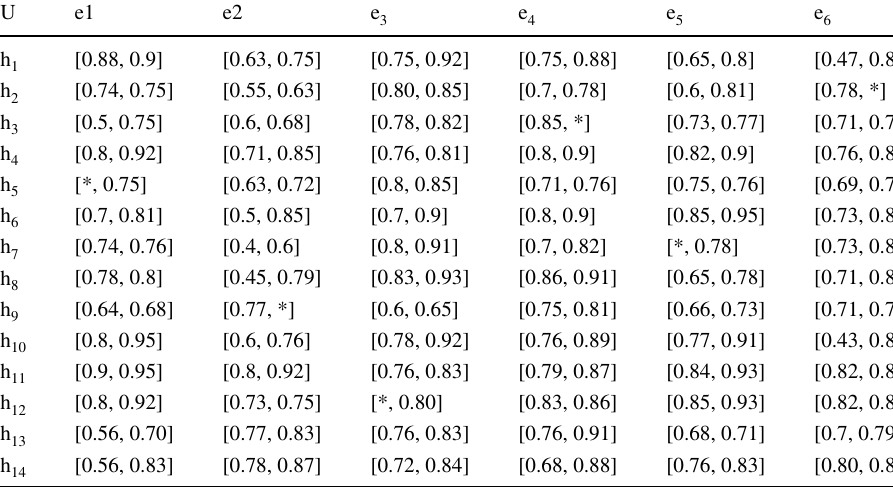
Table 1 An incomplete interval- valued fuzzy soft